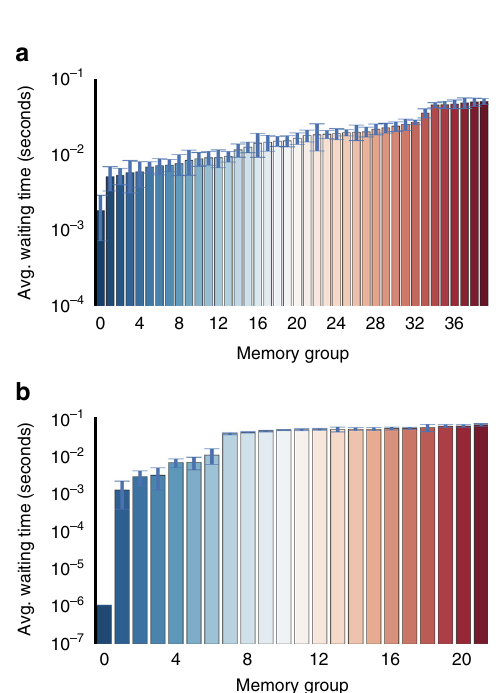
Fig. 5 Waiting times for a discrete- and a continuous-time Markov model. Results inferred from Beethoven ’ s fi fth symphony. a n = 1 discrete-time model, ignoring the waiting times between notes. b n = 2 continuous-time model, with waiting times incorporated into the inference. The error bars correspond to the standard deviation of the